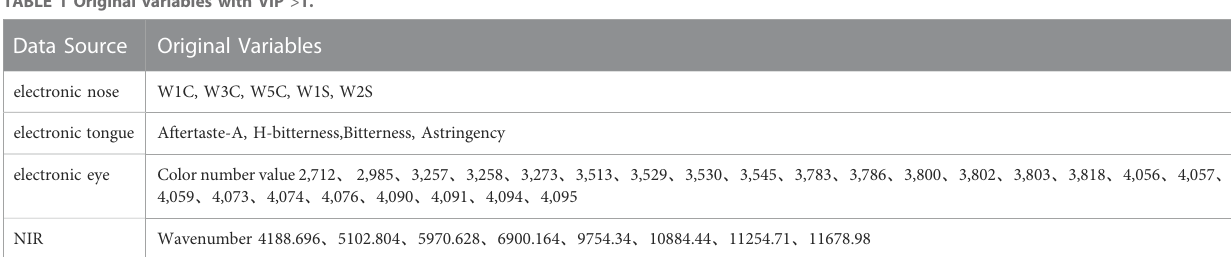
TABLE 1 Original variables with VIP >